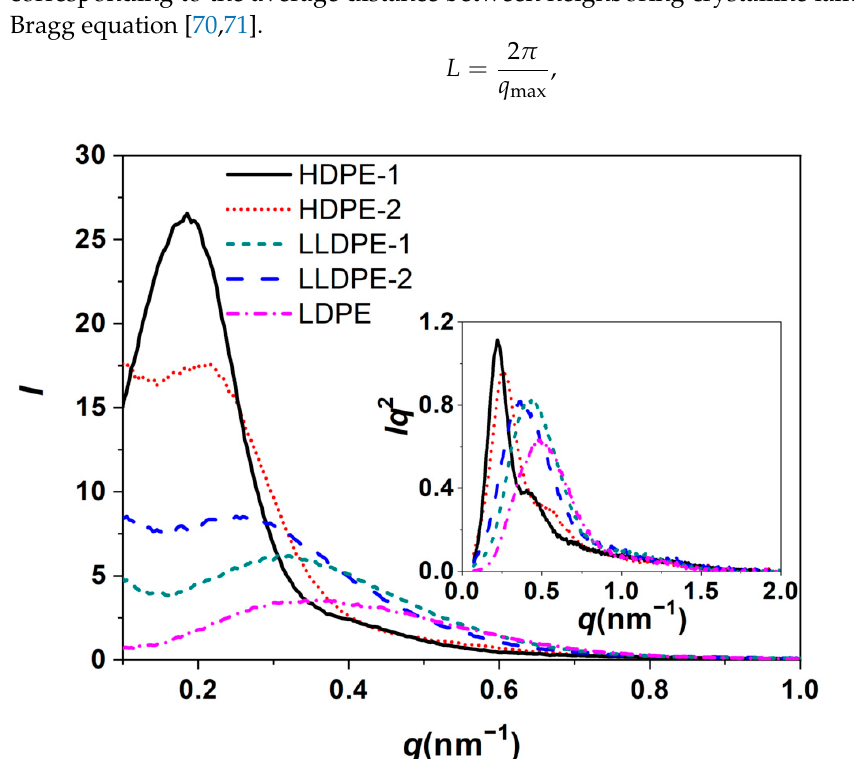
Figure 3. Linear and Lorentz-corrected SAXS profiles of the neat PEs used in this work. As seen in Figure 3, the q max value of the two HDPE resins was the smallest, while that of LDPE was the largest. It was suggested that the two HDPE resins had the largest long spacing, while LDPE had the smallest long spacing. The Lorentz-corrected SAXS profiles of the two HDPE resins exhibited a discernible shoulder peak, which may be attributed to the second-order scattering of the lamellae [43]. At the same time, it was found that the SAXS peak of the HDPE-1 was more well-defined and narrower than the HDPE-2. The respective average thickness of the crystalline and non-crystalline regions can be calculated from the one-dimension correlation function K ( z ) as follows [46,57,70].